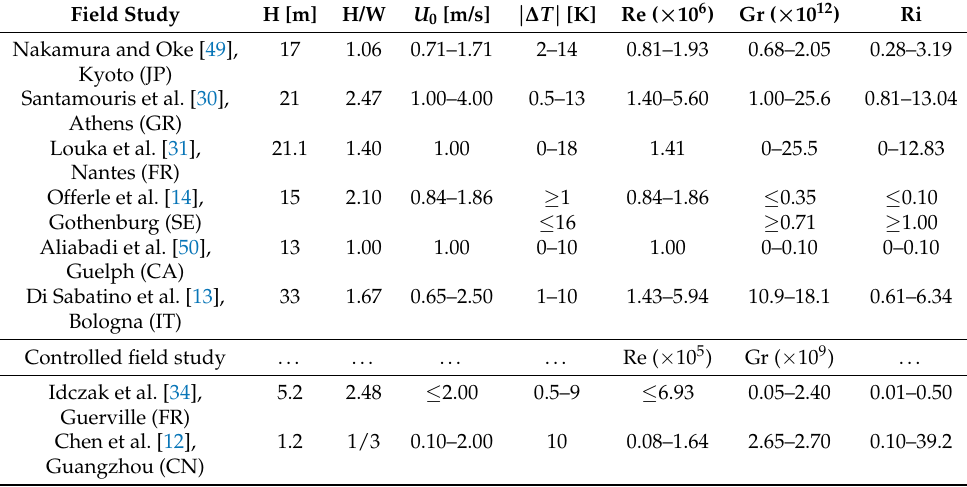
Table 2. Typical values of several thermo-dynamic quantities and parameters from field investi- gations. The dash highlights the values range, while values on different lines for are separately investigated in the reference